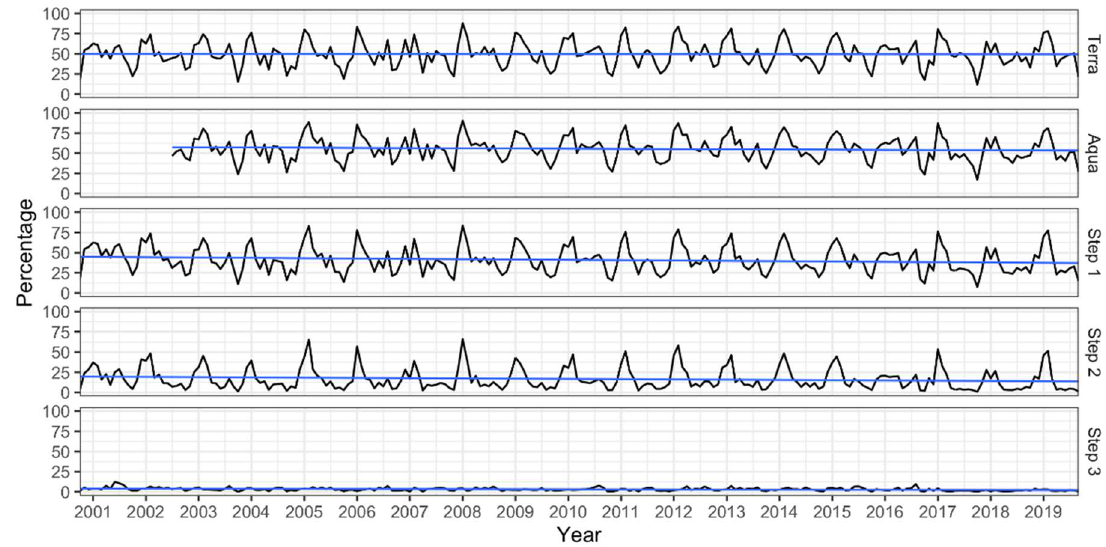
Figure 7. Monthly mean percentage of the cloud-covered pixels of MODIS daily snow product data featuring the reduction of cloud coverage (black line) and overall mean percentages (blue line) in three cloud reduction steps.